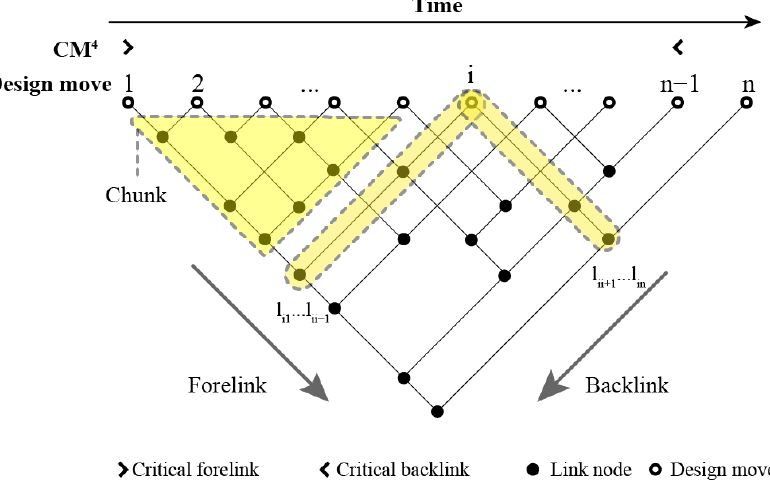
Figure 1. The linkograph production process and its common structures.